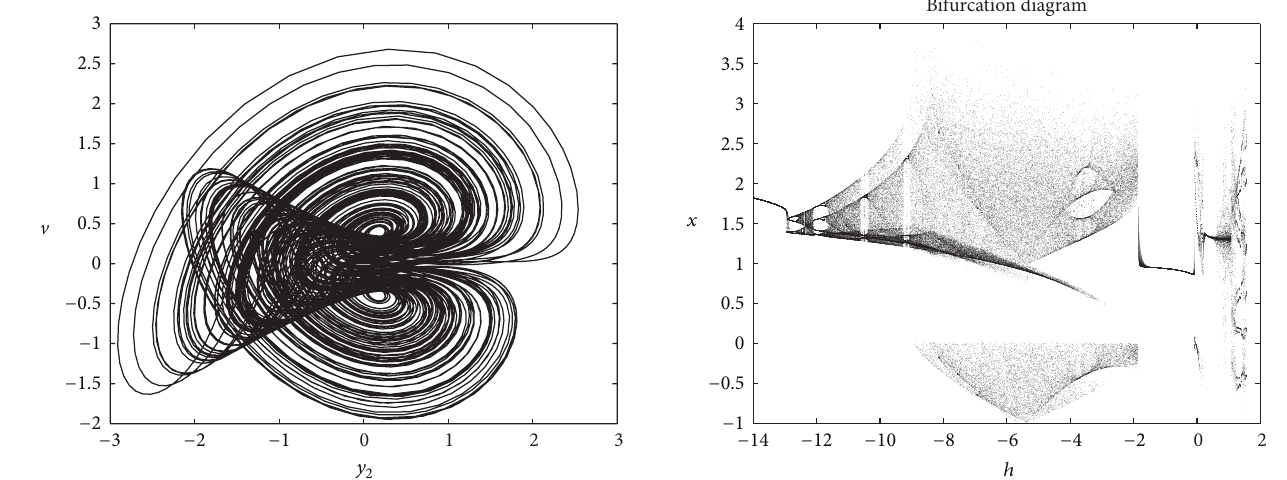
Figure 7: Bifurcation diagram of system